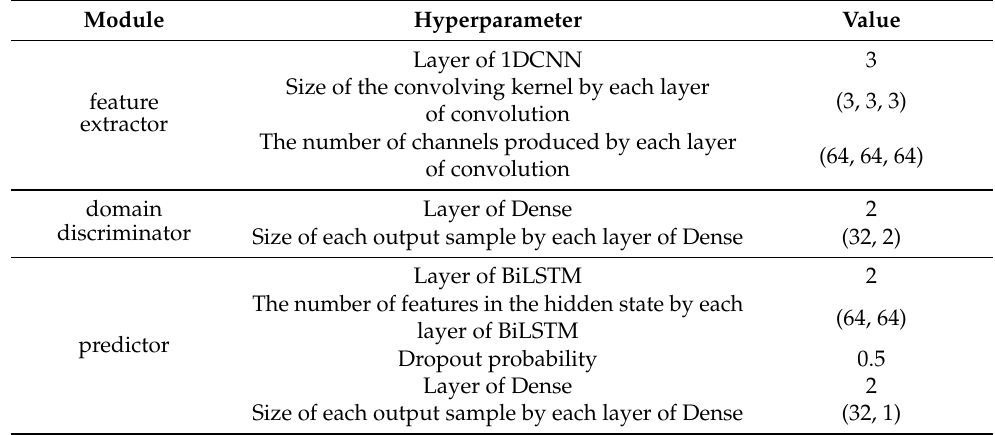
Figure 3. Model structure. C represents 1DCNN, L represents BiLSTM, F represents fully connected layer. Table 1. Model